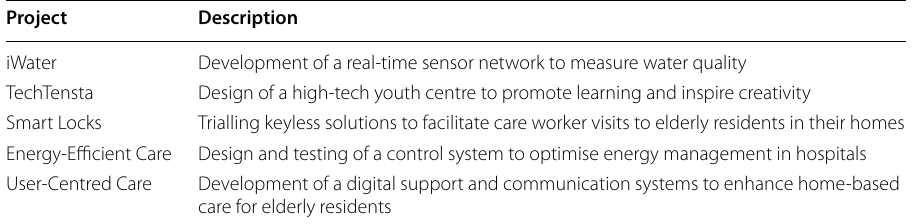
Table 1 Examples of Digital Demo Stockholm